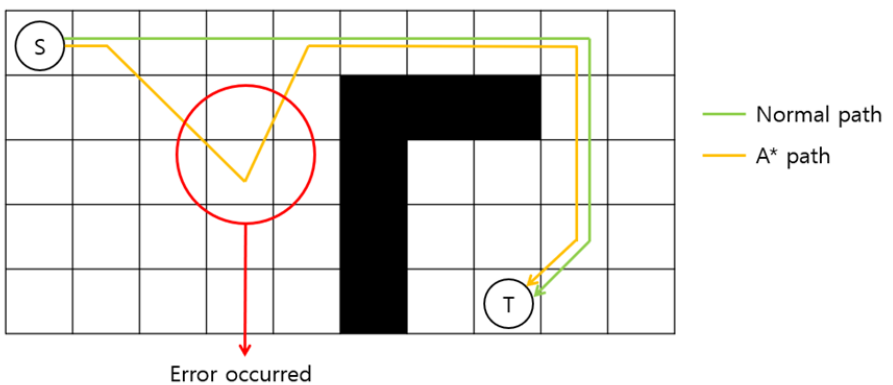
Figure 2. Distortion of the route when a topology map is not